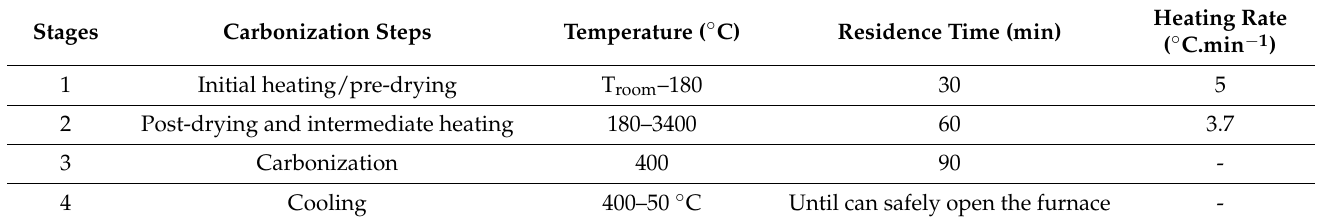
Figure 1. Samples collected for the characterization and biochar production tests. Table 1. Scheme of the programmable stages according to the temperature and residence time.